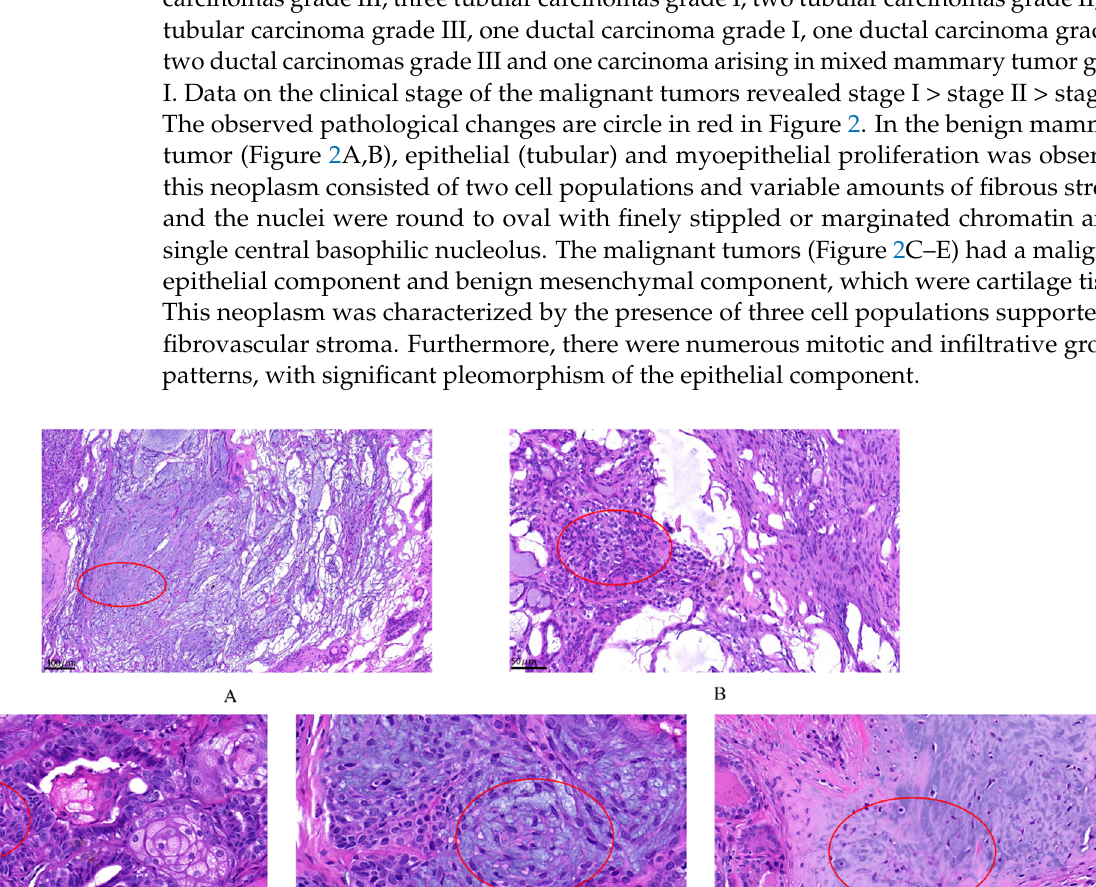
7 of 14 Figure 1. Clinical examination of canine mammary tumors. ( A , B ) are clinical observation pictures of canine mammary tumor diseases; the affected dogs were observed to have a distinct mass in the thorax, irregular in shape and sliding on palpation. Tumors were breakable, bleeding and ulceration during growth. ( C ) is a lateral view of the X-ray, the circle where a mass with slightly stronger den- sity than the surrounding tissue is seen, soft tissue opacity structures were observed along the bi- lateral peripheral abdomen, with no obvious metastasis of the tumor. ( D ) is an ultrasonography examination with normal organ echo, and without abdominal metastases detected.